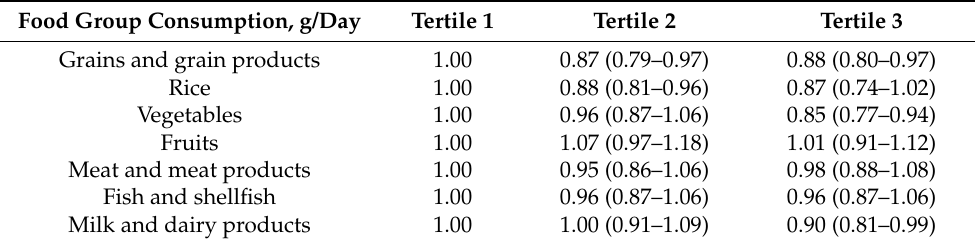
Table 5. Association between alcohol consumption and serum uric acid levels. Alcohol Consumption, g/Day Beta 1 Standard Error p Value Beer intake 0.0016 0.0003 <0.0001 Wine intake 0.00001 0.0009